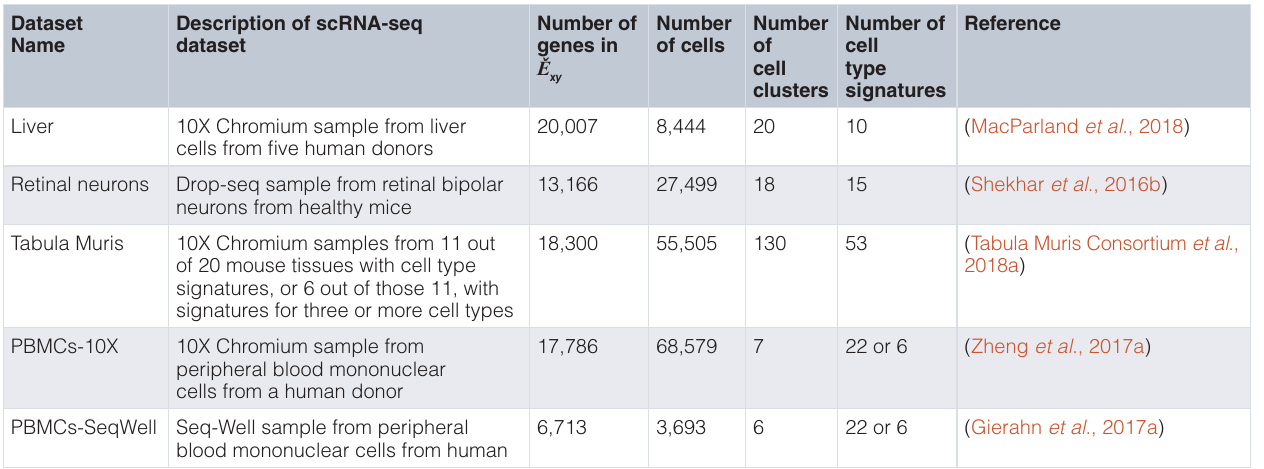
Table 1. scRNA-seq datasets used in this